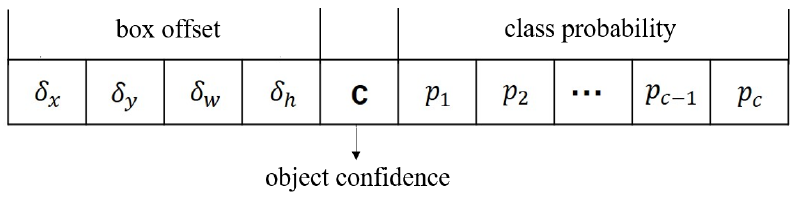
Figure 3. Output format per